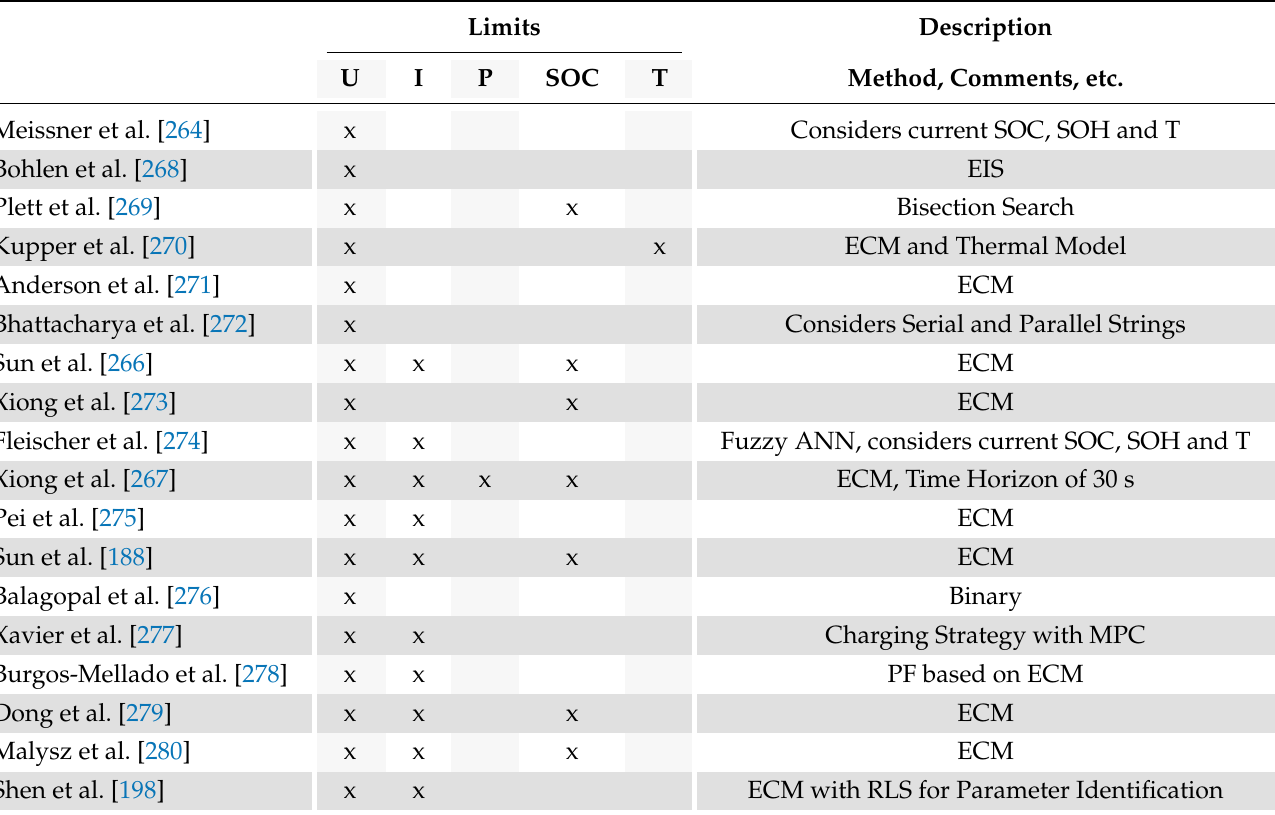
Table 5. Online SOF identification approaches. Abbreviations: Voltage (U), Current (I), Power (P), and Temperature (T), Model Predictive Control